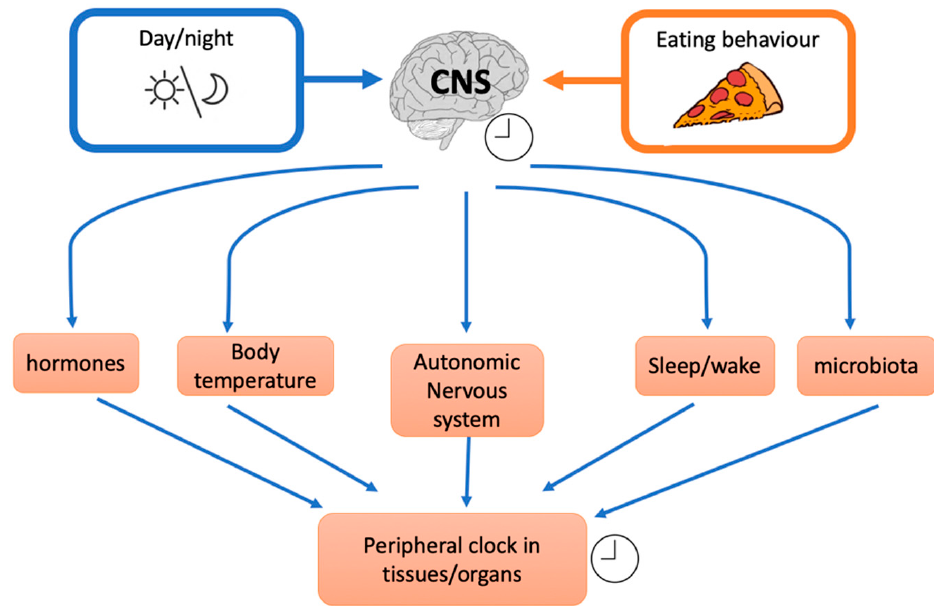
Figure 1. Effects of external factors on the inner central clock that influence different downstream mechanisms and peripheral clocks (CNS: central nervous system).